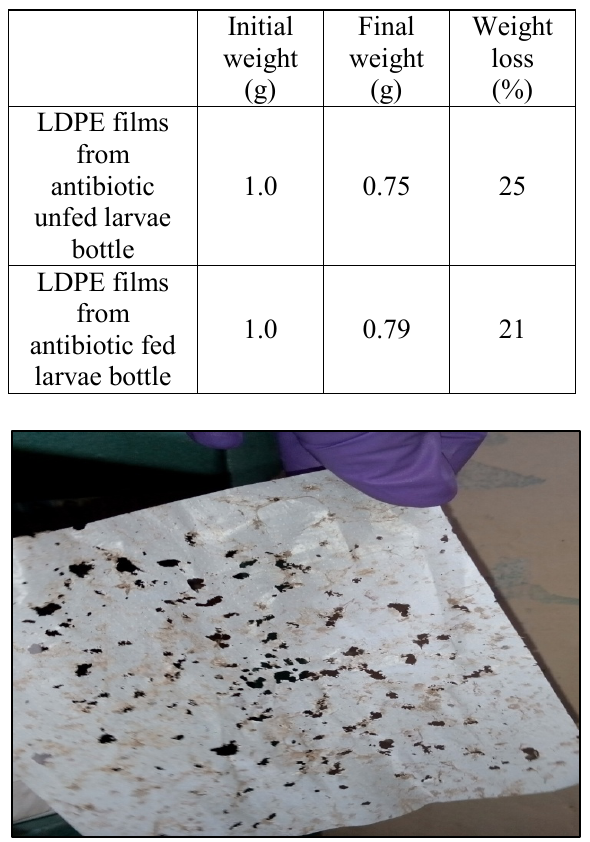
Table 1. Percentage of weight loss of LDPE